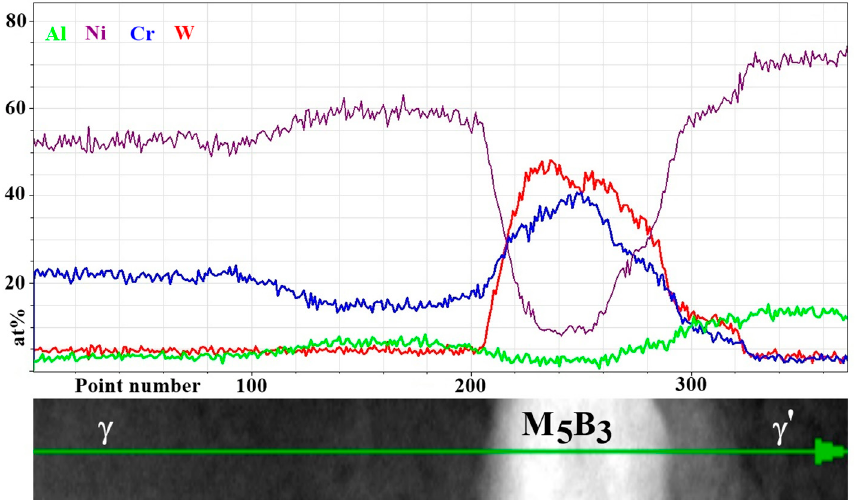
Figure 15. Distribution of selected alloying elements in γ , M 5 B 3 and γ ' phases, STEM-EDX.